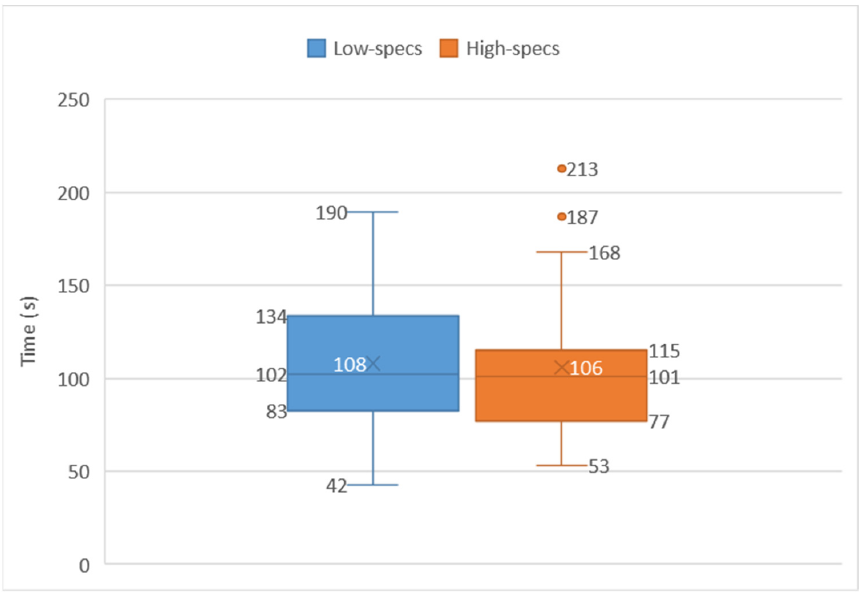
Information 2021 , 12 , x FOR PEER REVIEW Figure 10. Total time taken by participants to complete all tasks (calibration and annotation search).